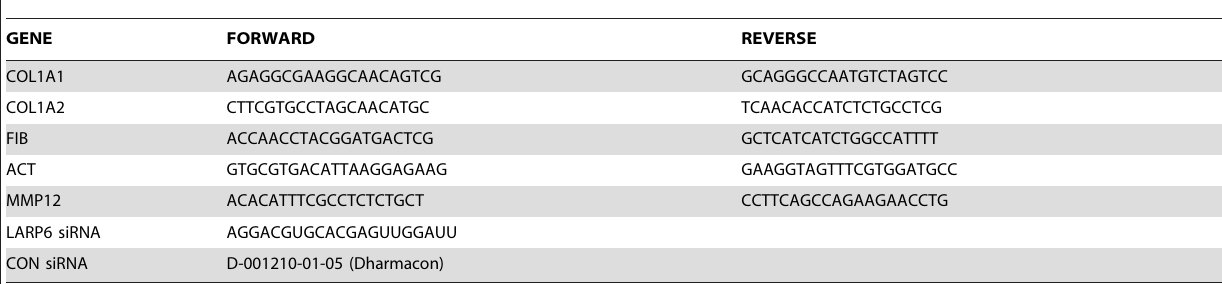
Table 1. Primers used for RT-PCR and sequences of